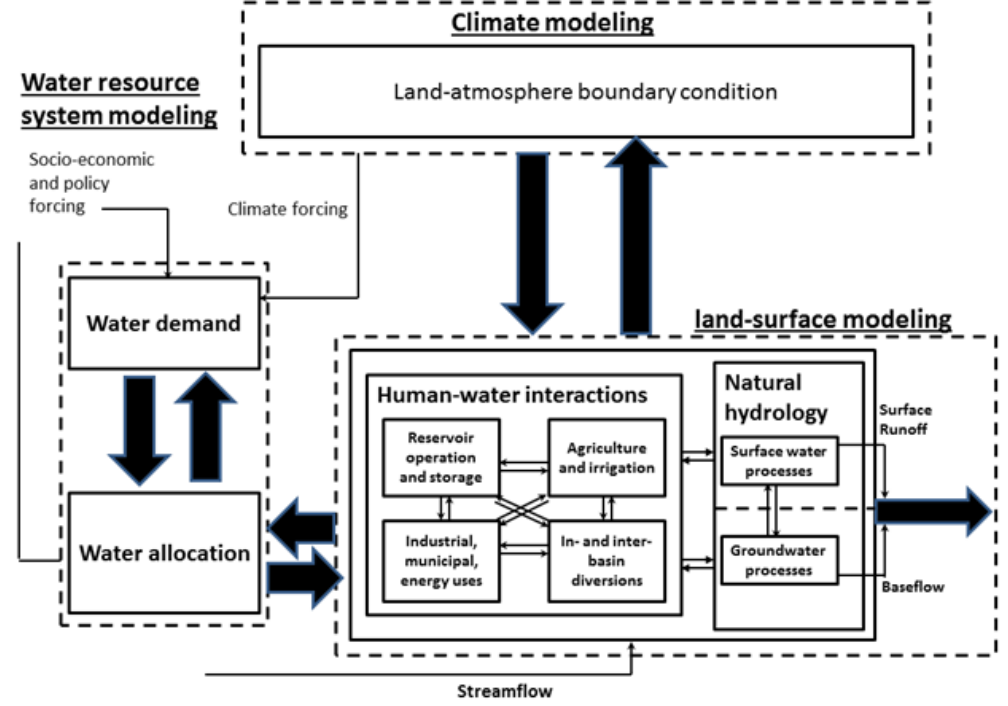
Figure 1. A fully coupled framework for inclusion of water resources management in a typical LSM